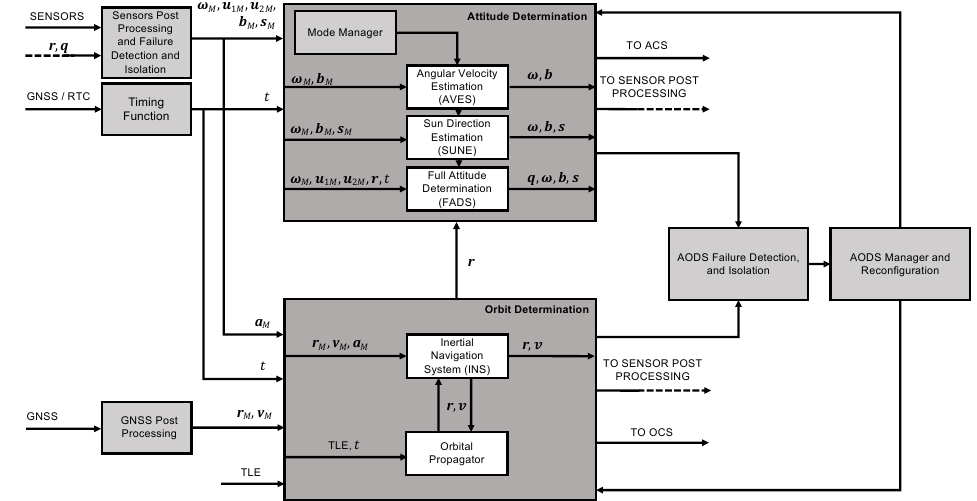
Figure 1. AODS architecture